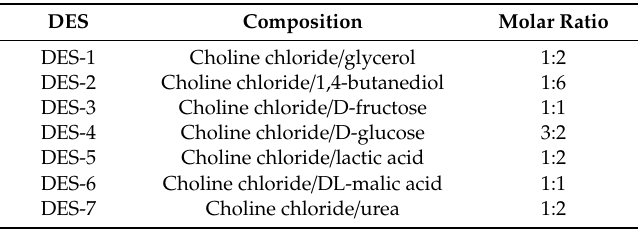
Table 4. Deep eutectic solvents used in this